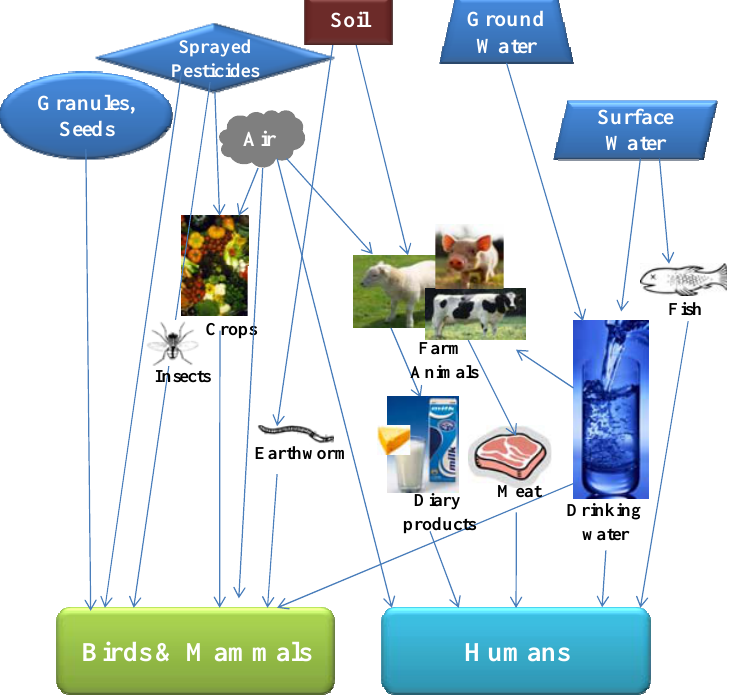
Figure 2. Schematic representation of the possible routes of environmental exposure of OP pesticides to humans and wildlife. Adopted from Reference